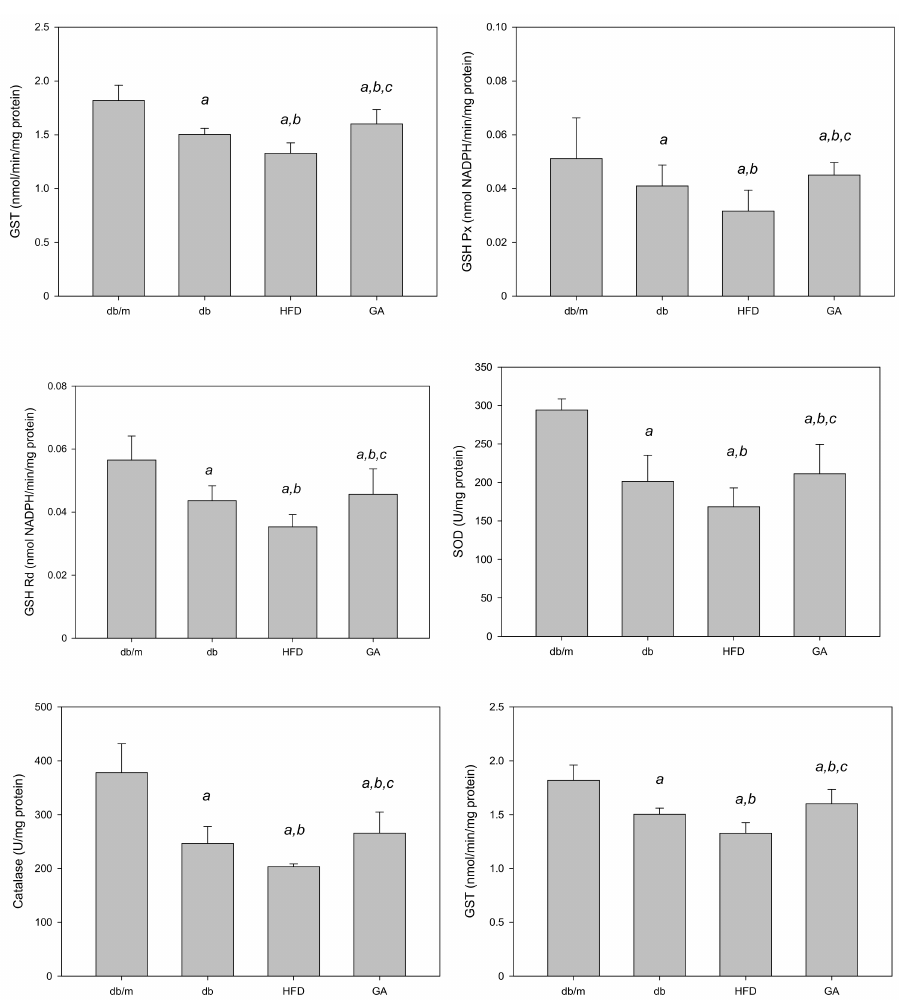
Figure 3. HFD reduced and GA enhanced the activities of hepatic antioxidant enzymes in diabetic mice. The 6-week-old male db/db mice were fed with HFD and 100 mg/kg GA for 12 weeks. Activity levels of GSH, GSH Px, GSH Rd, SOD, catalase and GST in the liver were analyzed. db/m, age-matched heterozygous mice fed with standard diet; db, db/db mice fed with standard diet; HFD, db/db mice fed with HFD; GA, db/db mice fed with HFD and GA. a, p < 0.05 compared with the db/m control group. b, p < 0.05 compared with the db group. c, p < 0.05 compared with the HFD